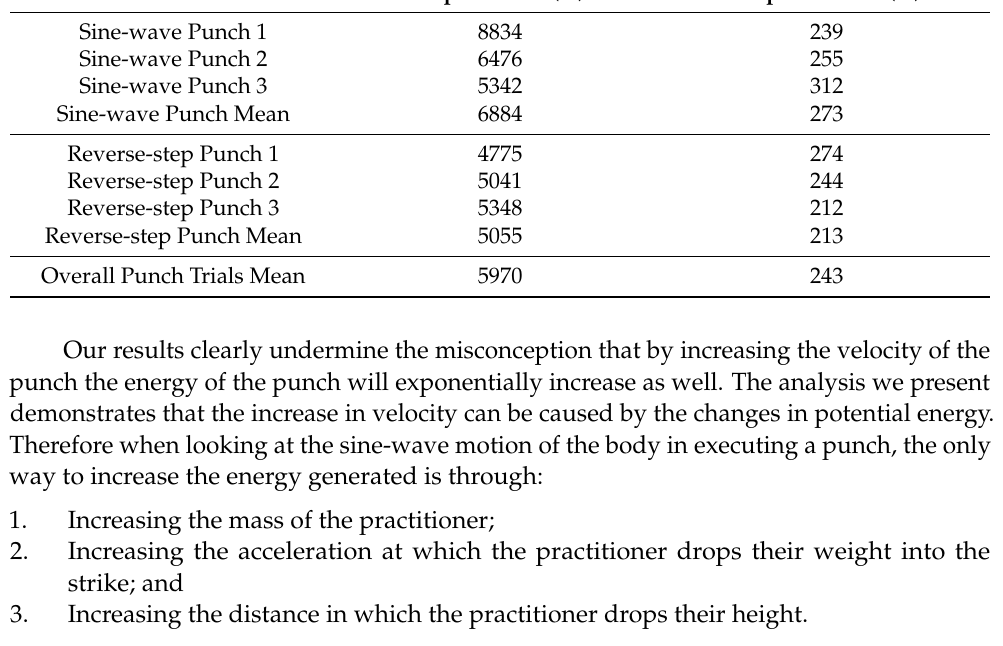
Table 6. Impulse and Impact Force results for Sine-wave punch and Reverse-step punch trials. Punch Trial Impact Force (N) Impulse Force (N) Sine-wave Punch 1